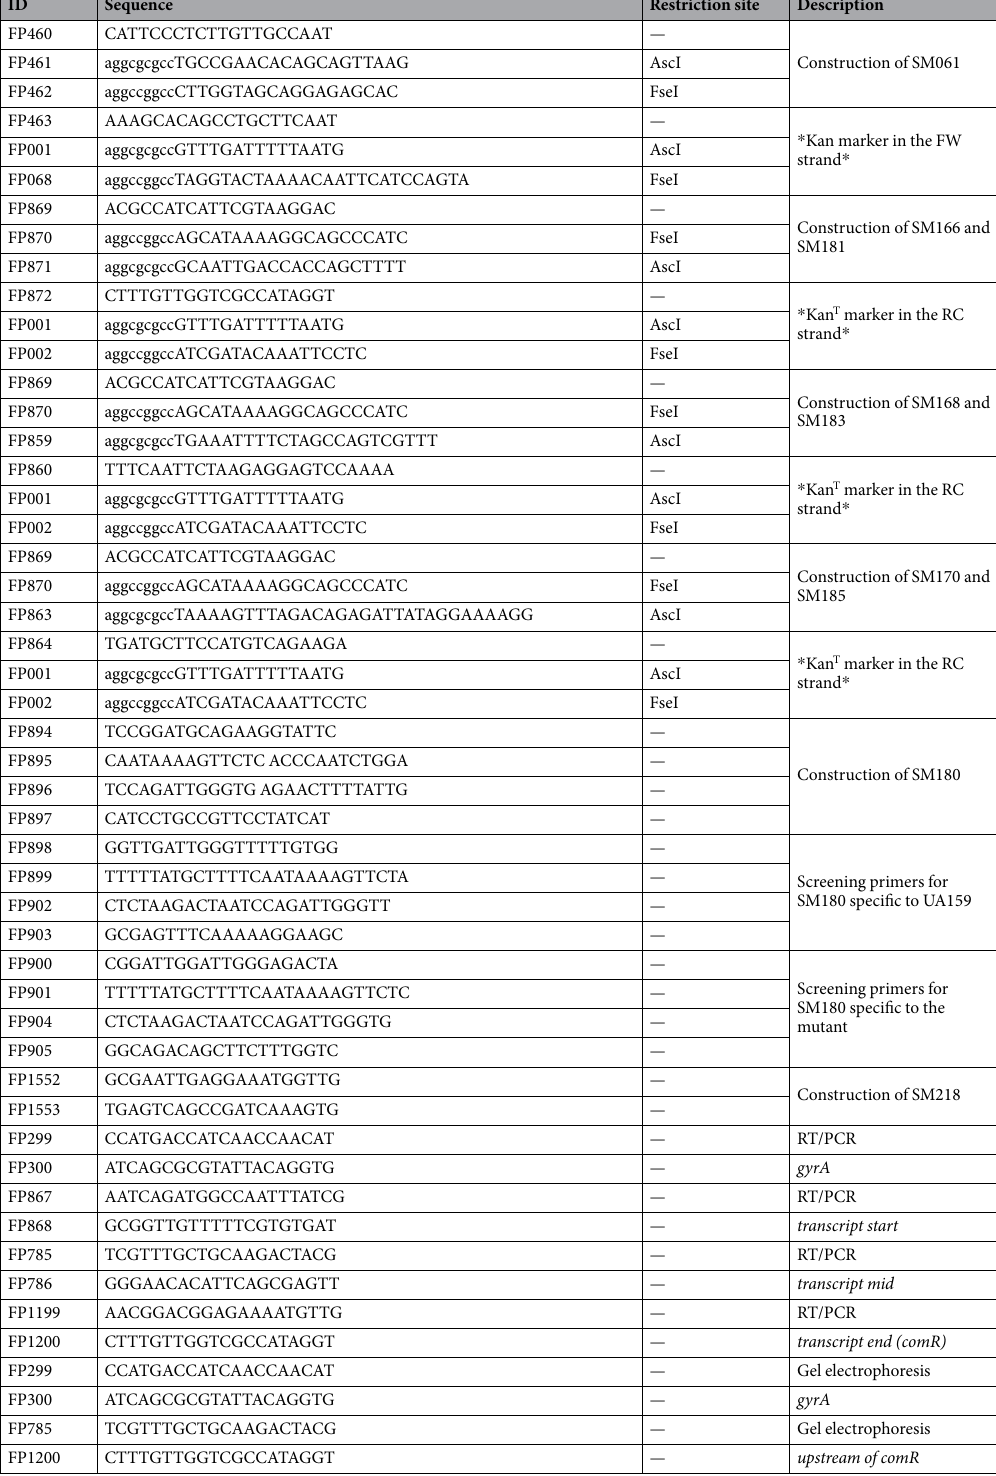
Table 2. Primers used in the